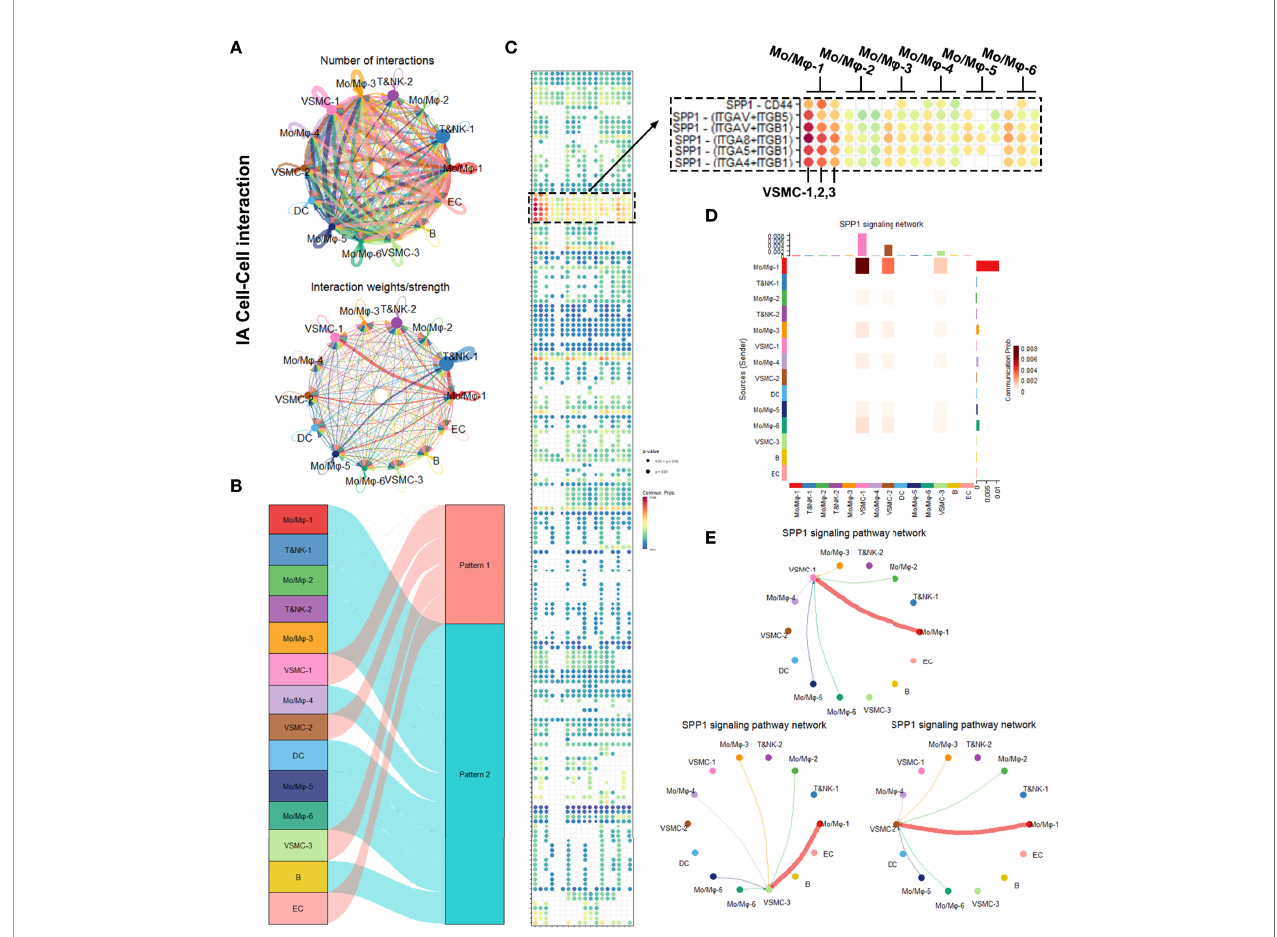
FIGURE 5 | Intracellular analysis between vascular smooth muscle cells (VSMCs) and macrophages in intracranial aneurysms (IAs). (A) Net plot showing the interaction number and strength. (B) River plot showing the communicating and working patterns in cells. (C) Network plot showing the speci fi c communicating pathways and their strength. (D, E) SPP1 signaling pathways between VSMC subclusters and macrophages in